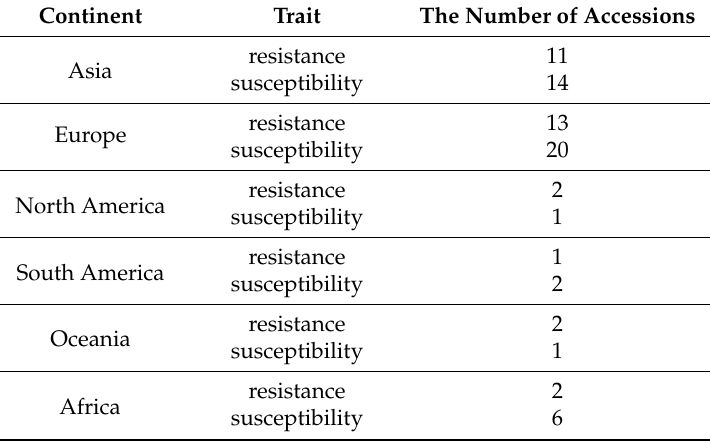
Table 2. The number of accessions for trait information about orchardgrass that distribute in 6 continents. Continent Trait The Number of Accessions Asia